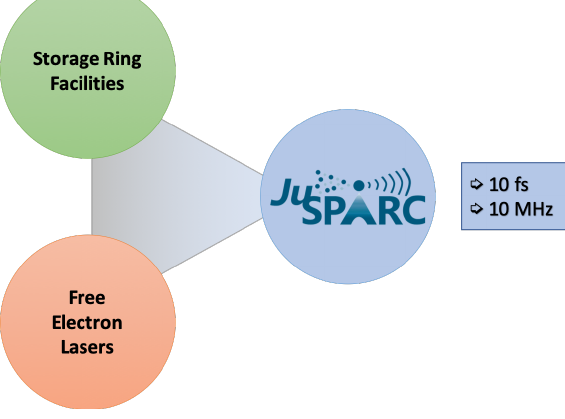
Figure 2: Positioning of Ju SPARC with respect to large-scale pulsed light